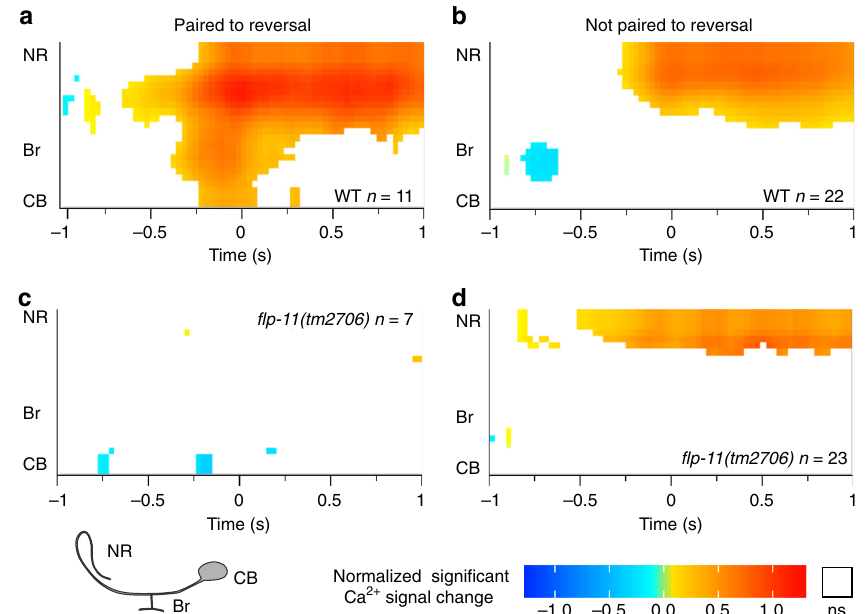
Fig. 7 Compartmentalized Ca 2 + dynamics in the RIS process. a , c Ca 2 + events paired to a reversal in the 2 s time window fl anking a Ca 2 + signal obtained from freely behaving animals (WT in a , fl p-11(tm2706) in c ). Top is the dorsal nerve ring (NR) region, passing through the branch region (Br) to the center of the cell body (CB). Only events signi fi cantly different from inactivity are shown, color coded for intensity, normalized and relative to the mean of the fi rst 150 ms depicted. Blue and red hues indicate signi fi cant reductions and increases, respectively. Non-signi fi cant dynamics are omitted and shown in white. b , d Ca 2 + events unpaired to a reversal in the 2 s time window fl anking a Ca 2 + signal, as in a , c . Number of events indicated. Signi fi cance level: T Test, p <